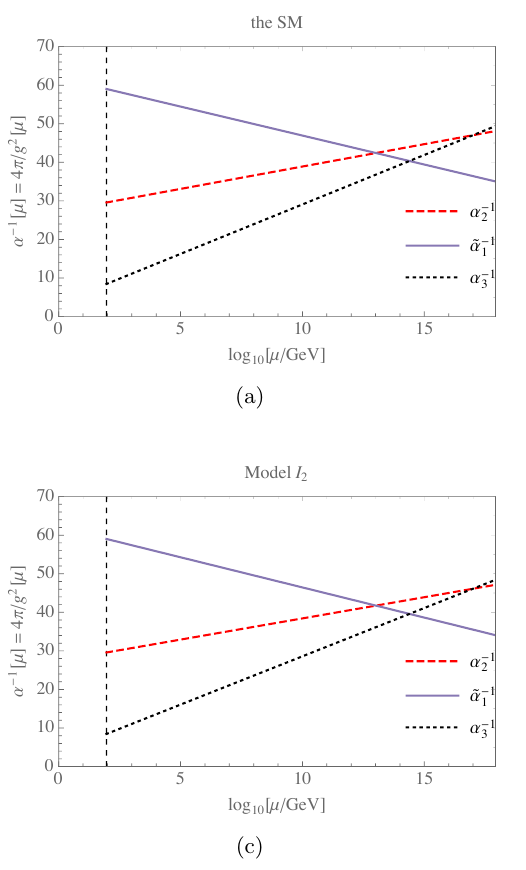
(cid:11) (cid:0) 1 (cid:17) 3 (cid:11) (cid:0) 1 . e 1 1 5